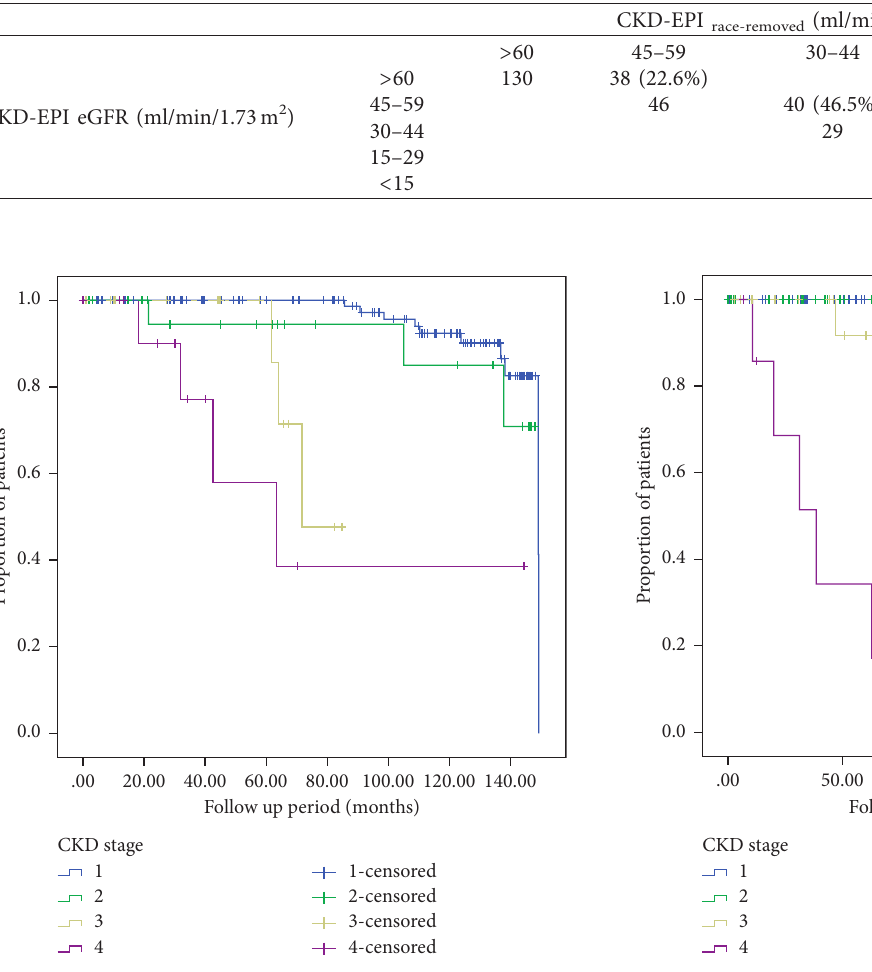
Figure 2: Kaplan–Meier curves depicting median time to CKD G5 amongst AA patients who were reclassified by MDRD race removed ( N �